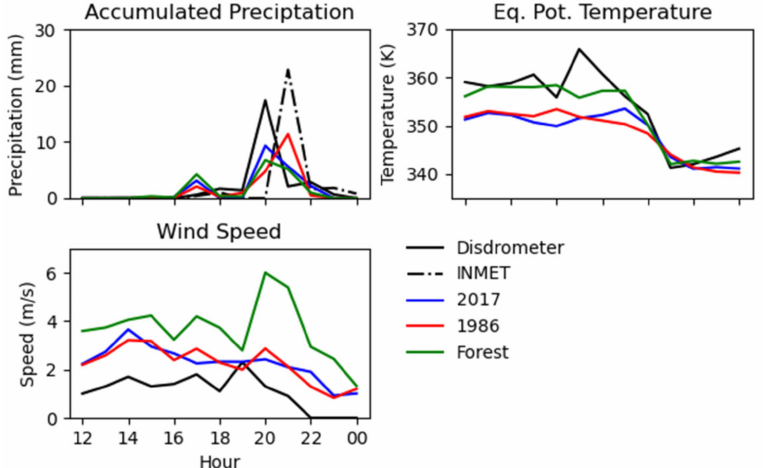
Figure 7. Time series of the accumulated precipitation (mm h − 1 ), the equivalent potential temperature (K), and the wind Speed (m s − 1 ) for the observed at the INMET Station (black solid lines, located at − 1.43 ◦ and − 48.43 ◦ ) and at the disdrometer (black dashed line, located at − 1.27 ◦ and − 48.45 ◦ ) and the 2017 scenario at the INMET Station point (blue solid line) and at the disdrometer (blue dashed